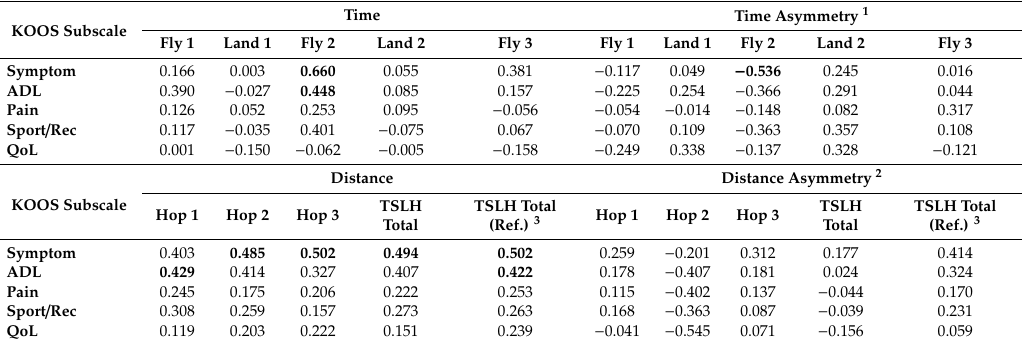
Table 3. Spearman’s correlation coe ffi cients between KOOS subscale scores and temporospatial parameters obtained with IMUs or measuring tape for the injured leg of the injured participants (G I ) during all TSLH phases. Significant correlations are marked with bold numbers. The abbreviations used in the table are as follows: ADL: KOOS Function in Daily Living subscale; Sport / Rec: KOOS Function in Sports and Recreation subscale; and QoL: KOOS Knee Related Quality of Life subscale. Correlation strength was interpreted very weak (0–0.19), weak (0.2–0.39), moderate (0.4–0.59), strong